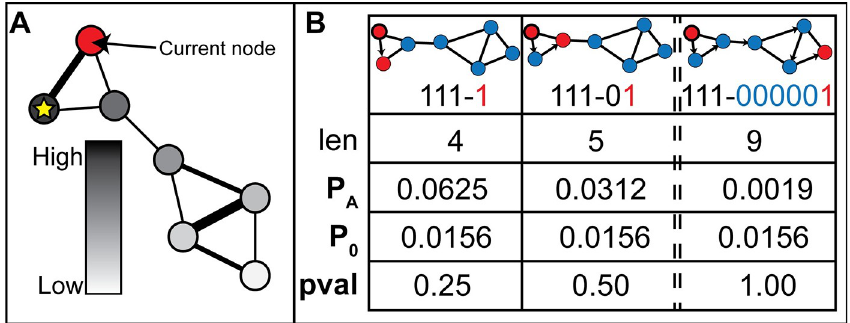
Fig 6. Diffusion of probability from a starting node and a diffusion-based encoding algorithm. (A) Node color denotes a gradient of probability inherited from the diffusion of probability from the current node (in red). The node with the yellow star denotes the node which inherited the highest probability. (B) A set is assigned higher probability (P A ) if it is highly connected and assigned lower probability if it is sparsely connected in the graph. The arrows point to the node the diffusion-based node ranking algorithm ranked highest, based on diffusion of probability from the previous encoded node. While the p-value of the most connected node set of size 2 for the graph illustrated here is 0.25, with larger graphs and larger subset sizes, the potential for further compression increases, and thus, more significant p- values are